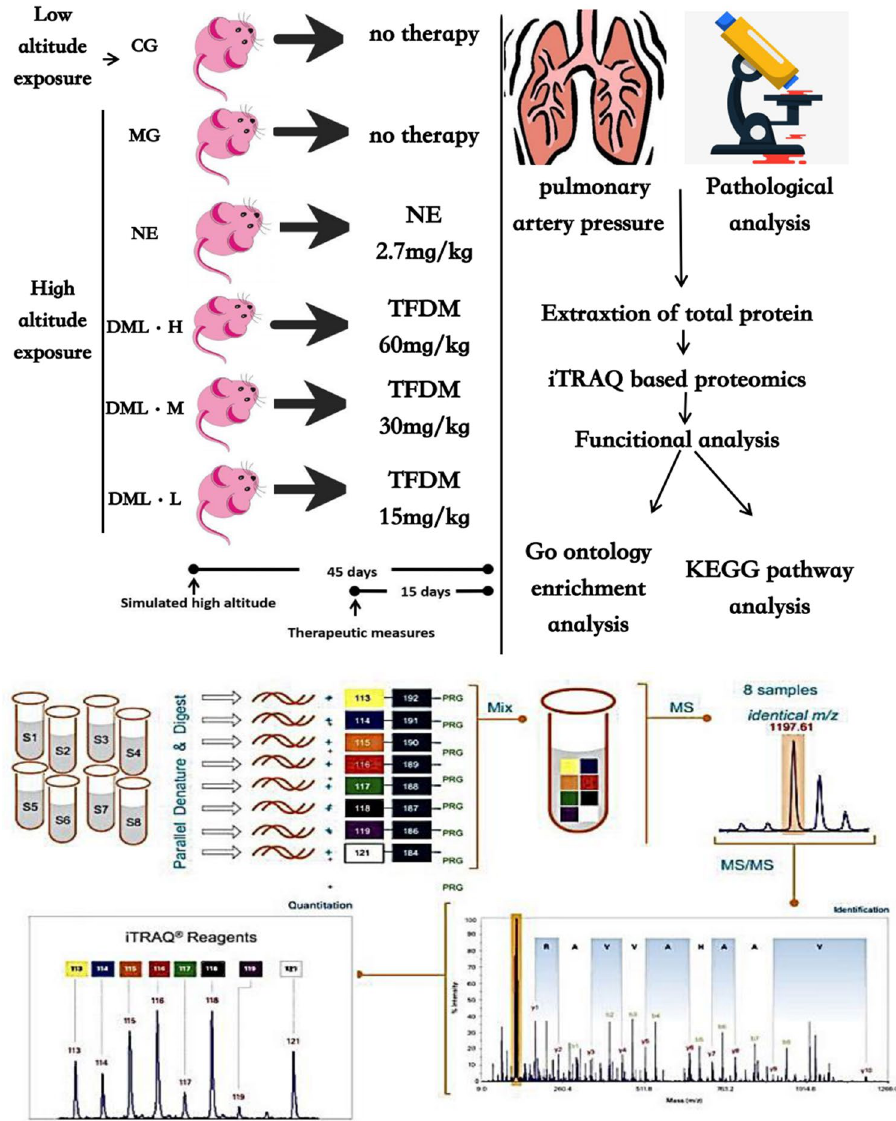
Figure 1. Workflow of iTRAQ analysis in a rat model of CMS. Rats were fed for 45 days under specific experimental conditions. Then, we measured the pulmonary artery pressure, the serum levels of Hb, and the Hct. We also investigated lung tissues and the pulmonary artery. The basic procedure for iTRAQ quantitative proteomics involved several steps: (1) extract protein from the sample, (2) quantify protein concentration, (3) analyze protein samples and evaluate whether the sample quality met the requirements of subsequent experiments, (4) perform reduction alkylation treatment on protein samples that met the quality standards, (5) Take an equal amount of trypsin for each sample and hydrolyze, (6) Label peptides with iTRAQ reagents, (7) mix the labeled peptides in equal amounts, (8) pre-separate the mixed peptides, (9) carry out LC–MS/MS analysis, (10) use the Sequence or Mascot module in Proteome Discoverer to search the database, and (11) perform statistical and bioinformatic analysis using data derived from the database